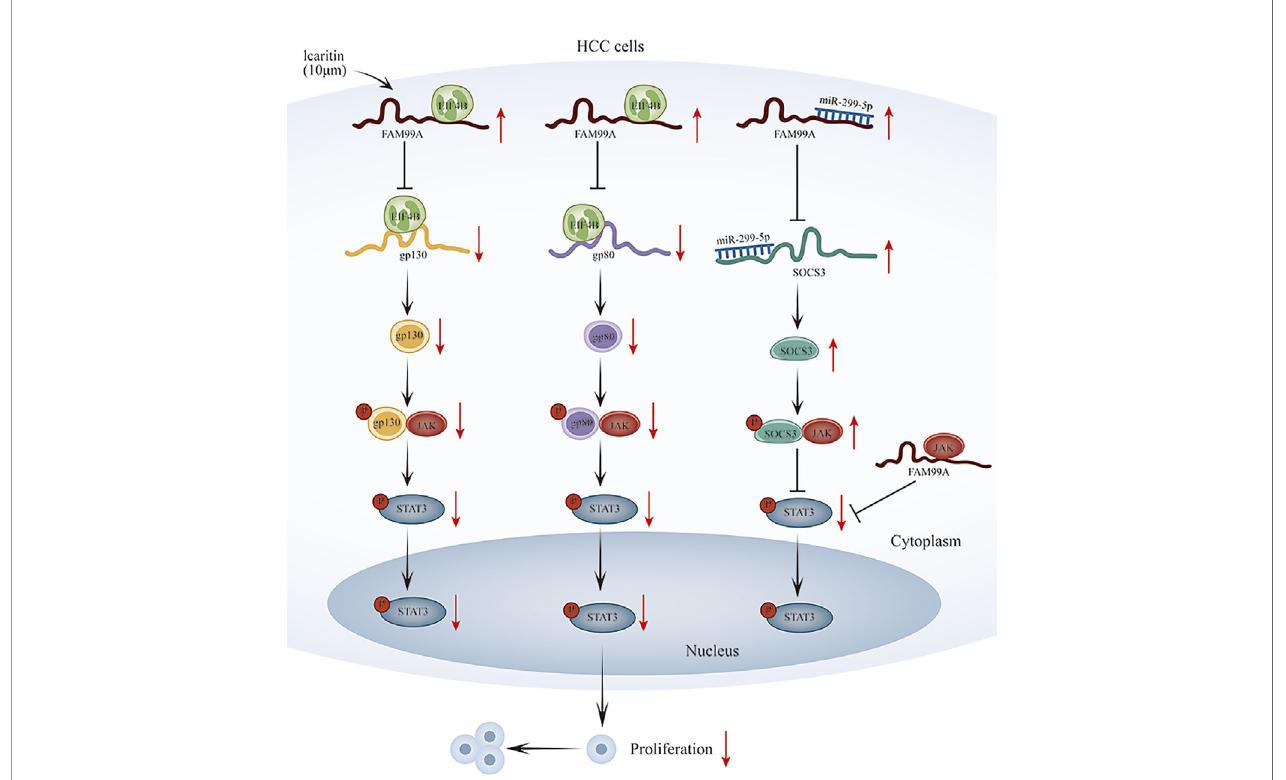
FIGURE 9 | Schematic diagram of icaritin-induced FAM99A affects glycolysis via regulating the JAK2/STAT3 signal pathway in